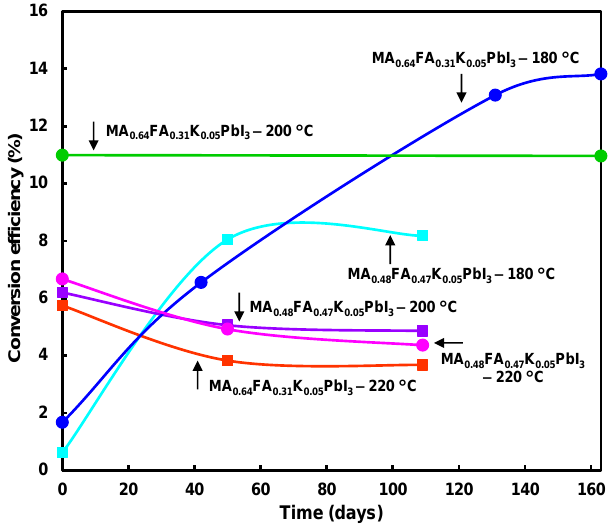
Figure 3. Changes of photoconversion efficiencies of the present perovskite photovoltaic devices. Changes to the J-V characteristics of the MA 0.64 FA 0.31 K 0.05 PbI 3 device, prepared at 180 °C, are